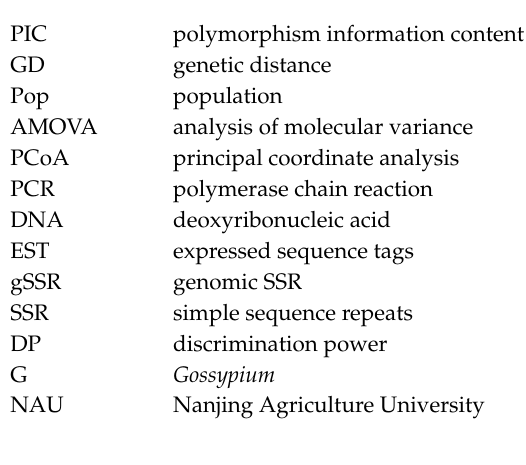
Figure S1: Dendrogram based on neighbor-joining (NJ) method, Table S1: The characteristics of mined genes from SSR marker regions, Table S2: GO functional annotations of EST-SSRs and gSSRs, Table S3: Summary of 49 genes with differential expression during fiber development, Table S4: RNA seq expression data of 108 genes with differential expression of both up and down regulation and Table S5: Markers with physical positions and PIC